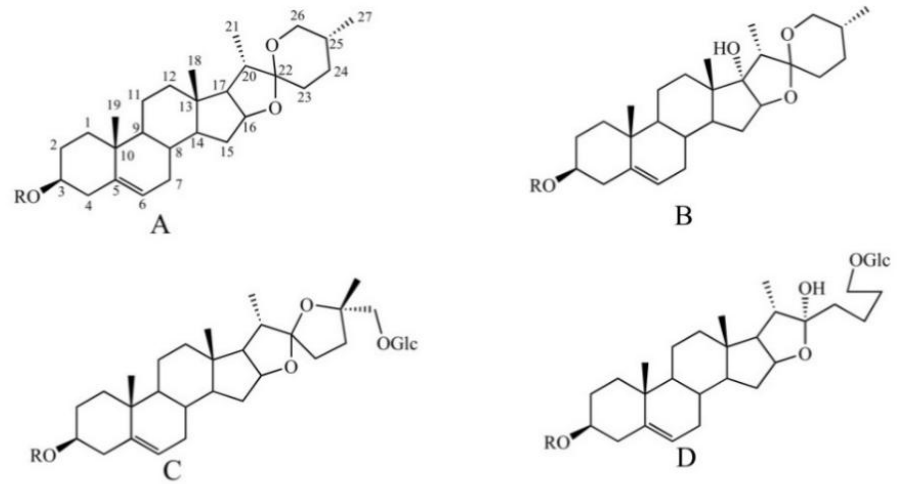
Figure 2. The steroidal saponin skeleton identified from different parts of PPL in positive ion mode. A. Diosgnin−type; B. pennogenin-type; C. nuatigenin-type; D. furost-type. Seven compounds (33, 34, 45–47, 71, and 73) were classified as diosgenin − type saponins. The mass spectra of these compounds indicated the fragmentation ions at m/z 415, 397, and 253 [21,22]. Among them, the content of compound 44 was the highest. Compound 44, the molecular ion of which was located at m/z 1031.5416 ([M + H] + ), showed the main fragmentation ions at m/z 869.4898 [M + H − Glc] + , 577.3749 [869.4898 − 2Rha] + , and 415.3219 [577.3749 − Glc] + . The fragmentation ions at m/z 397.3113 and 271.2063 could be formed by successive losses of H 2 O (18 Da) and C 8 H 16 O 2 (144 Da). Therefore, com- pound 44 was identified as pariphyllin A [23]. The fragmentation pathways of compound 44 are proposed in Figure 3. Seven compounds of this type were identified and have been reported previously in PP [23,24].